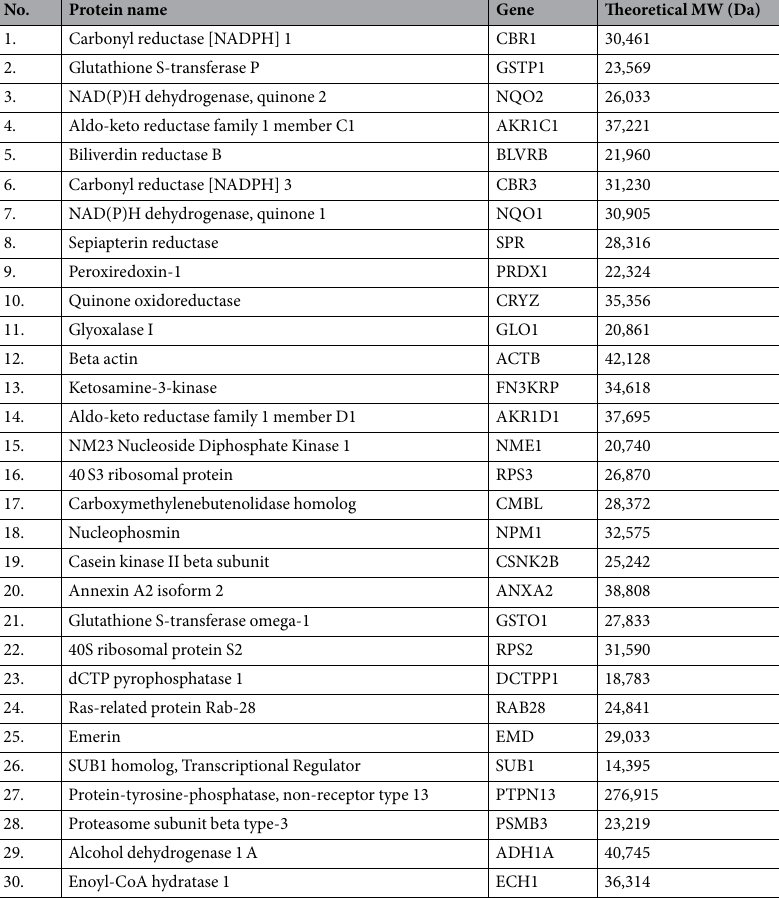
Table 1. Candidate curcumin-binding